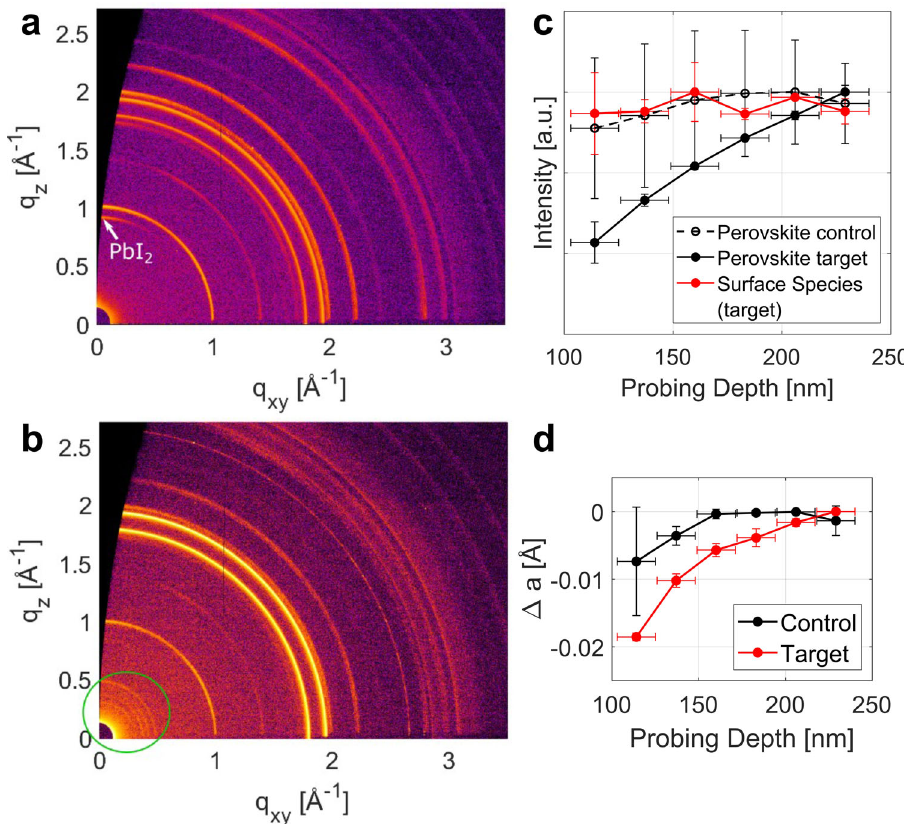
Fig. 2 Structural characterization of perovskite fi lms. a – b GIWAXS two-dimensional reciprocal space maps of a control sample, b treated sample at an incidence angle of 0.12°, probing the surface of the material. Low q signals of the new surface species are marked with a green circle. Measurements were done under vacuum conditions. c Peak intensities of different crystal phases as a function of the estimated probing depth, normalized to their respective maximum value for control and treated samples. The intensity of surface species is approximately the same for the probed depth (red). d Relative change in pseudo-cubic unit cell parameters as a function of probing depth. Values were calculated from radial pro fi les of reciprocal space maps and averaged over two sets of samples. GIWAXS probing depth was varied by changing the angle of incidence of the X-ray beam from between 0.12 and 0.3°. The error in the probing depth (horizontal error bars) was estimated from the angular error due to the surface roughness of the sample. The vertical error bars were determined from the standard deviation from repeated measurements on two sets of